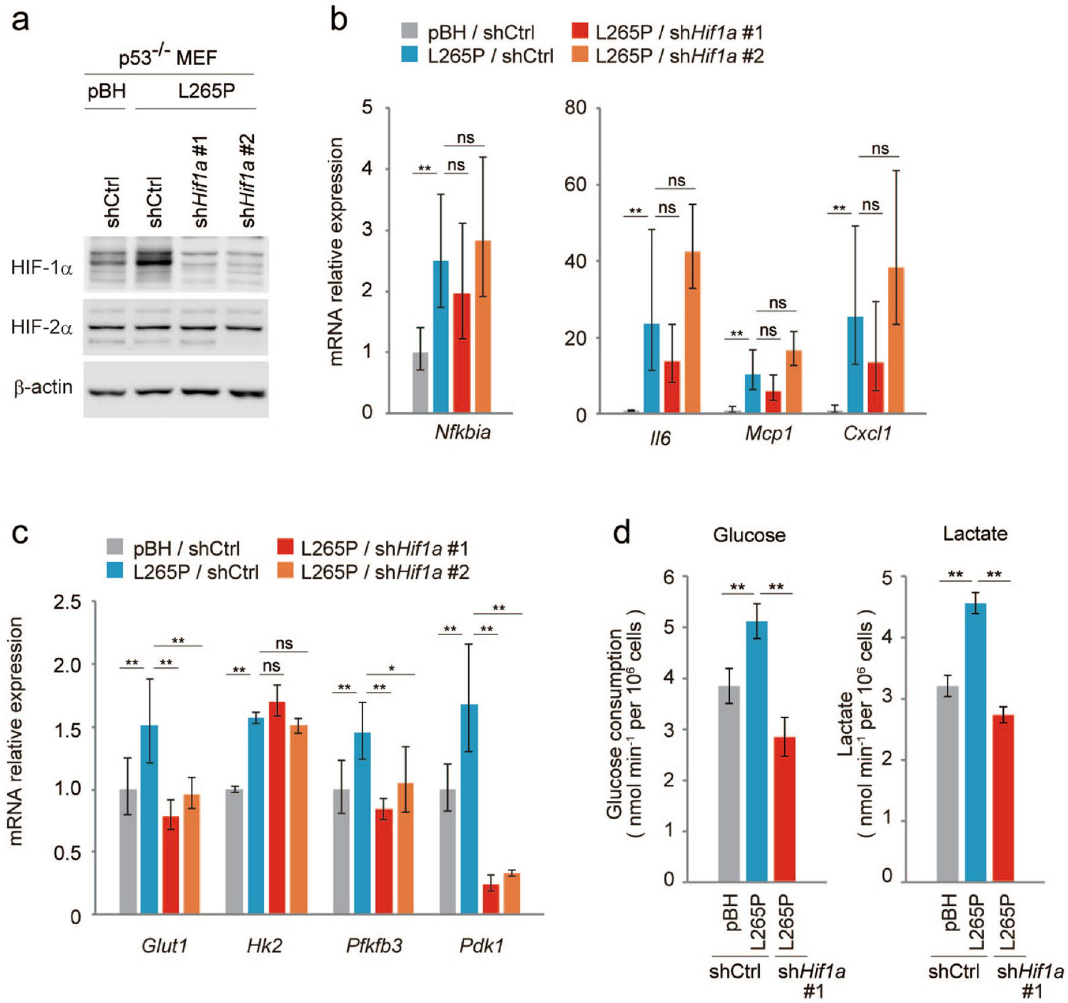
Figure 3. Suppression of HIF-1α does not affect NF-κB activation but reduces glucose metabolism in MYD88 L265P-expressing p53 -/- MEFs. Reduced HIF-1α expression by shRNA (#1 and #2) in p53 −/− MEFs expressing MYD88 L265P. ( a ) Total cell lysates were analysed by immunoblotting. ( b ) Gene expression of NF-κB targets measured by qPCR. ( c ) Expression of glucose metabolism-related gene mRNAs quantified by qPCR. ( d ) Glucose uptake and lactate production were measured using sh Hif1a #1. The quantified results are presented as the mean ± s.d. (n = 4) using one-way ANOVA followed by Scheffe’s F test. *P < 0.05, **P < 0.01. ( b , c ) The y-axis values are the relative fold change for gene transcripts normalised to β-actin. Data represent the mean ± s.d. (n = 3) using one-way ANOVA followed by Scheffe’s F test. *P < 0.05, **P <